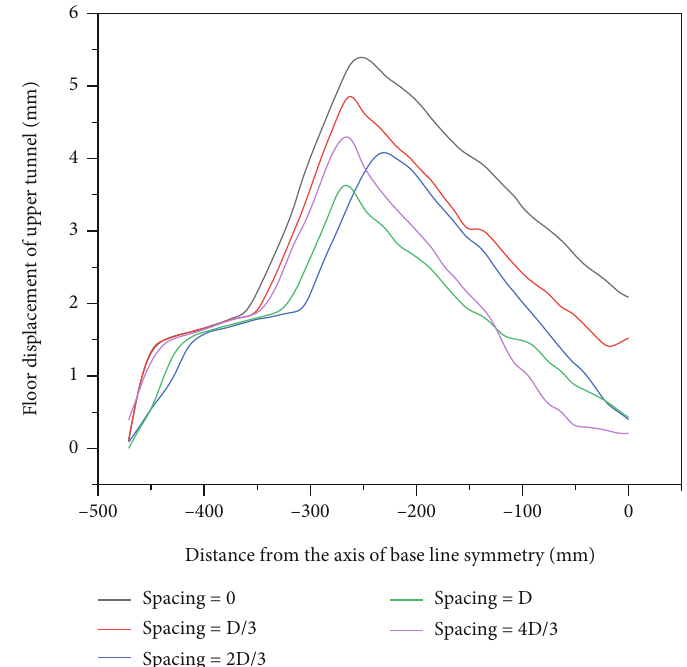
Figure 11: Displacement curve of upper tunnel fl